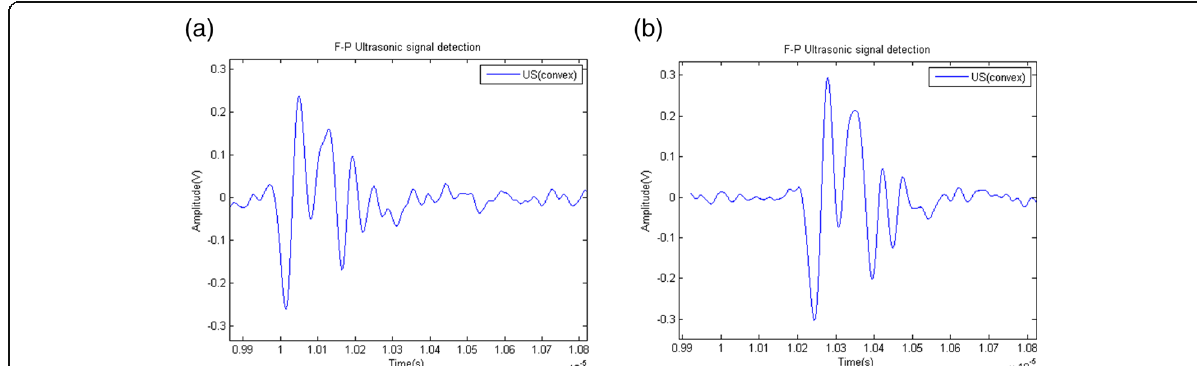
Fig. 4 Frequency response calibration: F – P measured time-domain signal. The fiber is placed vertically and inserted into the tank, as shown in Fig. 3. The bottom of the tank is a layer of transparent film, and the bottom of the cling film is the ultrasonic transducer, which is vertically upward relative to the optical fiber. The distance between the end face of the optical fiber and the transducer is approximately 1 mm. The signal is measured by adjusting the distance and coupling angle between the transducer and the optical